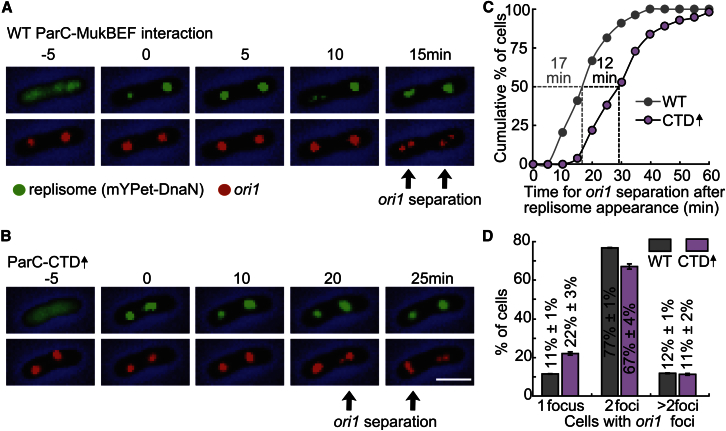
The MukB-ParC Interaction Stimulates ori Decatenation(A) Example cells from the time-lapse experiments with wild-type cells transformed with empty expression plasmid (pBAD24). Black arrows show time of ori1 segregation. 0 min time was defined by replisome appearance at ori1.(B) Example cell showing ParC-CTD 3-hr overexpression.(C) Cumulative distribution of times of ori1 locus segregation after replication initiation, marked by appearance of mYPet-DnaN foci at ori1.(D) Snapshot analysis of the number of ori1 foci/cell in steady-state cells. Mean ± SD of three independent experiments (>1,000 cells).